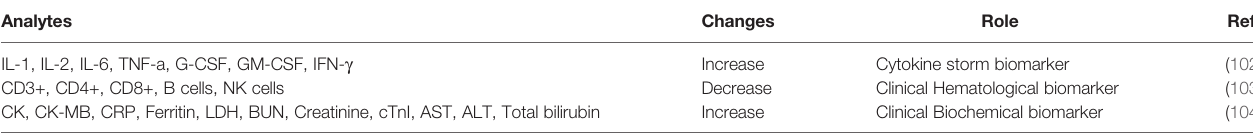
TABLE 2 | Potential biomarkers of disease severity in COVID-19.